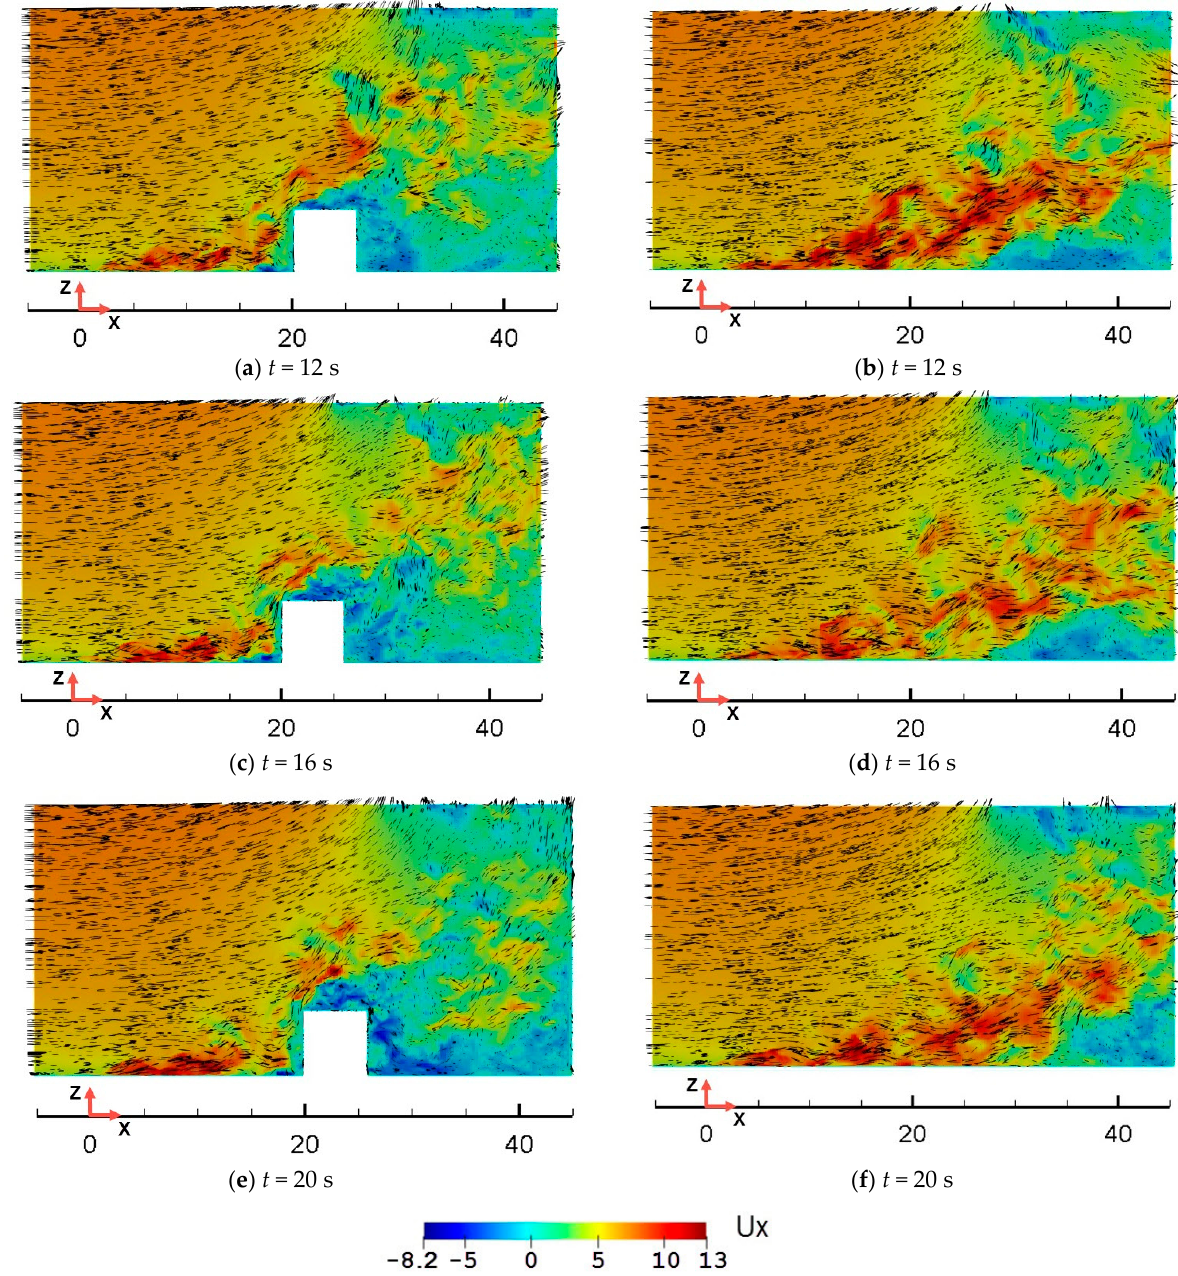
Figure 3. Vertical transects of instantaneous streamwise velocity component ( U x ) and corresponding velocity vectors ( U ref = 6m/s, t = 12 s, 16 s, 20 s) at different lateral locations. ( a ) t = 12 s, y = 0 m ( b ) t = 12 s, y = 9 m ( c ) t = 16 s, y = 0 m ( d ) t = 16 s, y = 9 m ( e ) t = 20 s, y = 0 m ( f ) t = 20 s, y = 9